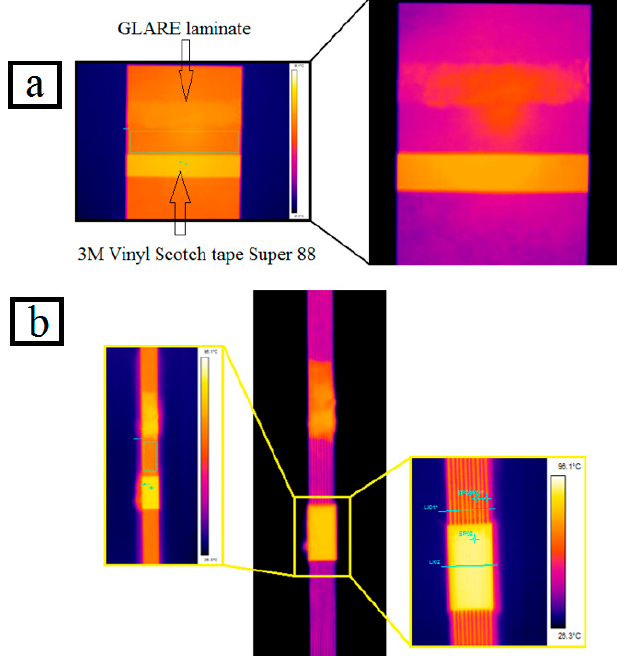
Figure 3. ( a ) Measuring the emissivity of top and bottom surfaces of GLARE laminate in third test. ( b ) Measuring the emissivity of the side of GLARE laminates in the third